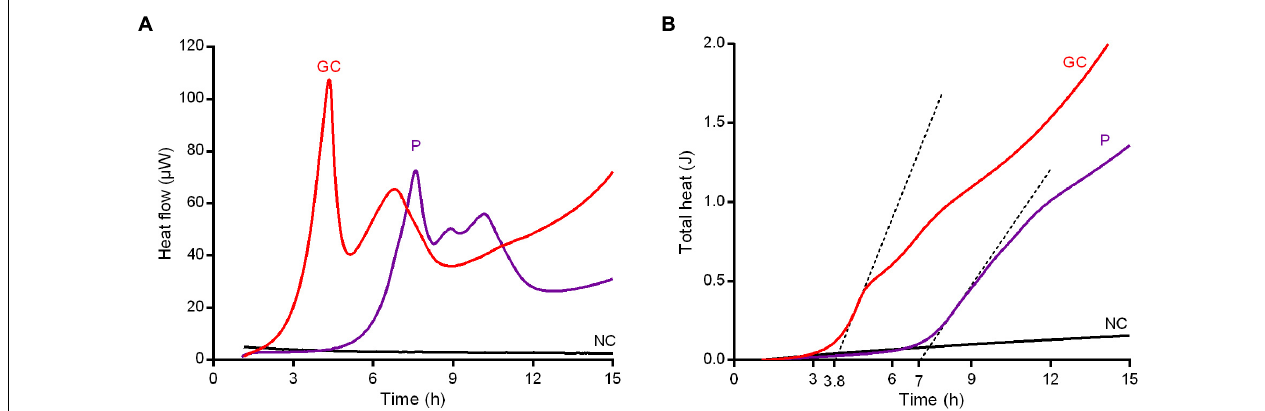
FIGURE 7 | Characterization of persister cells isolated from MRSA biofilm after 24 h-treatment with 1024 µ g/ml vancomycin. Revival assay in CAMHB by IMC monitoring (A) the heat flow ( µ W) plotted against time (h) and (B) the total heat (J) produced during the experimental time (h). GC, growth control; P, persister cells; NC, negative control. Representative data of replicated experiment are reported.